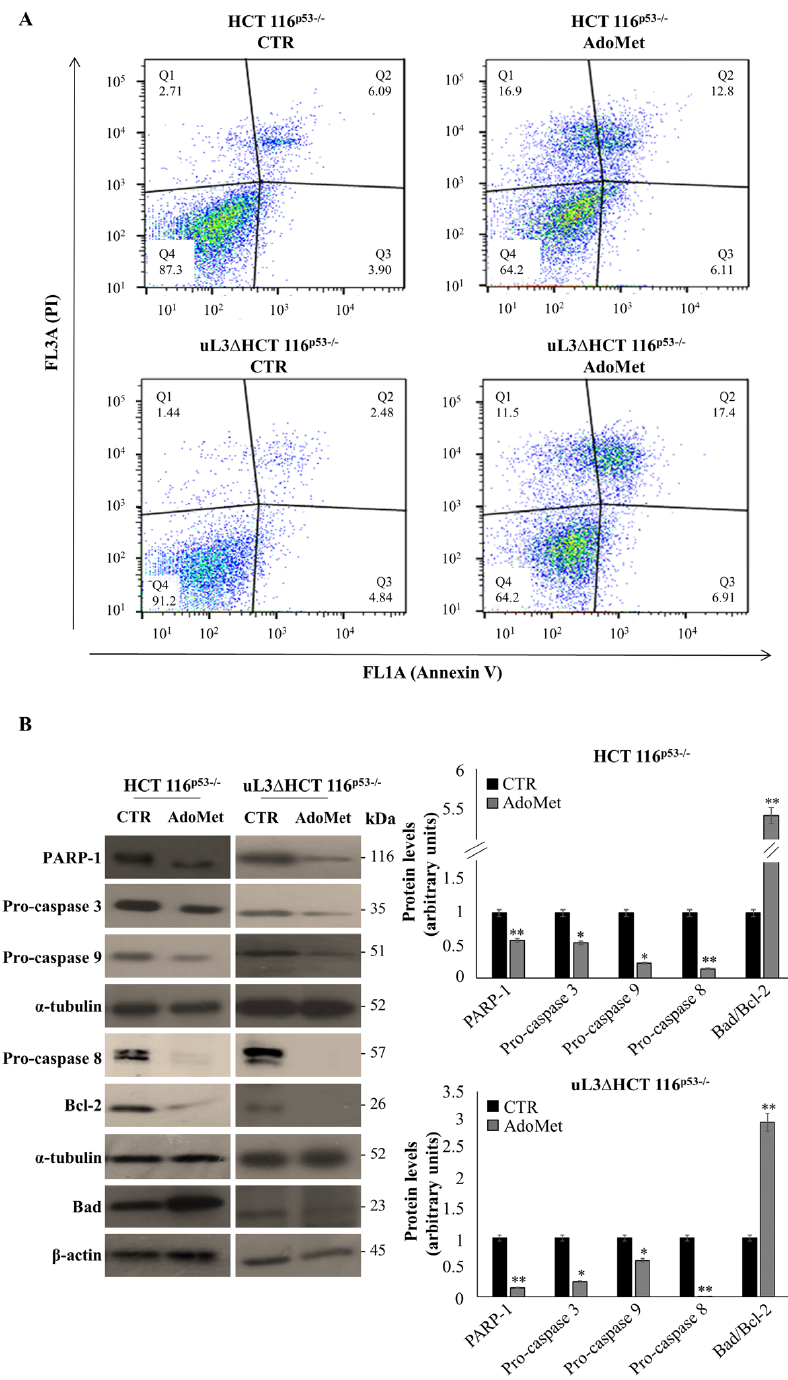
Figure 4. Effect of AdoMet on apoptosis in HCT 116 p53 − / − and uL3 ∆ HCT 116 p53 − / − colon cancer cells. ( A ) Representative dot plots of Annexin V-FITC and PI-stained HCT 116 p53 − / − and uL3 ∆ HCT 116 p53 − / − cells incubated with 500 µ M AdoMet for 72 h. The experiments were repeated three times. ( B ) Immunoblots of HCT 116 p53 − / − and uL3 ∆ HCT 116 p53 − / − for PARP-1, pro-caspase 3, pro-caspase 8, pro-caspase 9, Bad, and Bcl-2; the housekeeping proteins α -tubulin and β -actin were used as loading control. Graphs show the relative densitometric analyses, expressed as arbitrary units. Bars represent the mean of triplicate experiments; error bars represent the standard deviation. * p < 0.05, ** p < 0.01 vs. untreated cells set at 1. The images are representative of three immunoblotting analyses obtained from three independent experiments. Full-length blots are shown in Figure S2.